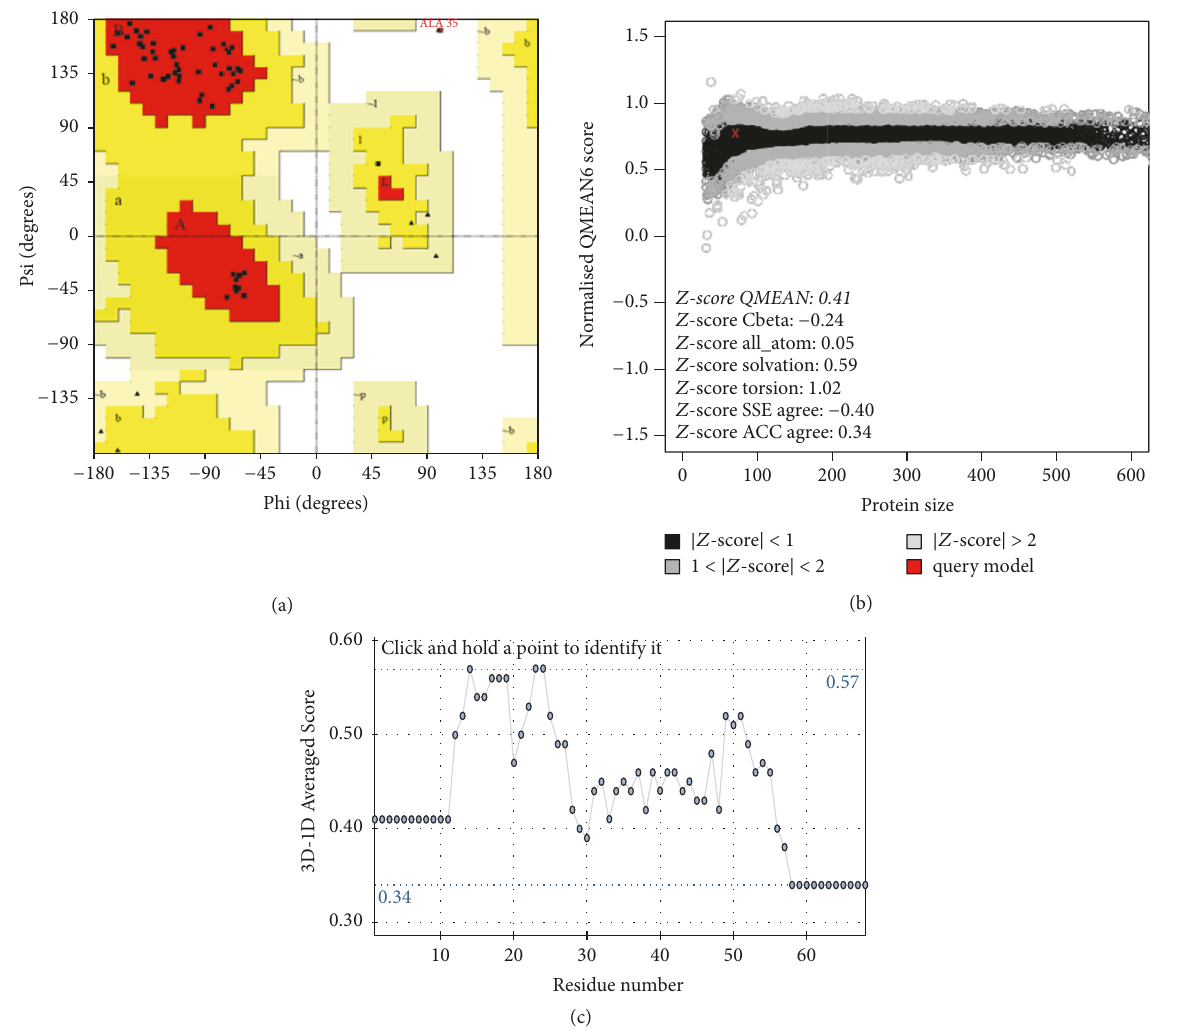
Figure 4: Tertiary structural model assessment . (a) Ramachandran plot of protein model generated by PROCHECK. The position of 96.4% amino acids within the generated structural model are within most favored regions. The position of 1 amino acid (ALA-35, red text) is found within a disallowed region. (b) Graphical output of estimation of absolute quality of model via QMEAN6. The position of the Dm-Csp1 tertiary model is indicated by a red X. (c) Verify3D output data for Dm-Csp1 predicted tertiary structure, yielding an acceptably high score of